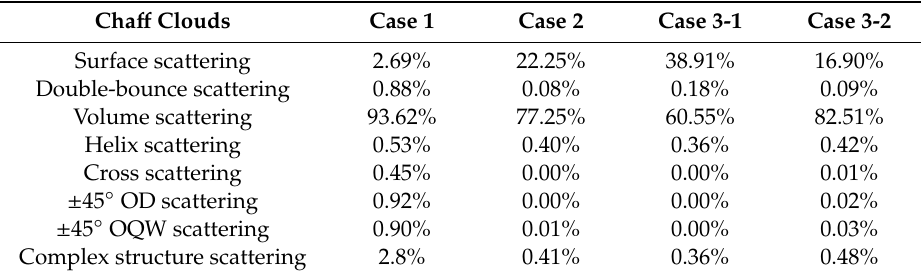
Figure 5. Decomposition results for chaff clouds in different cases. ( a ) Case 1. ( b ) Case 2. ( c ) Case 3-1. ( d ) Case 3-2. (red: double-bounce scattering, green: volume scattering, blue: surface scattering). Table 1. Scattering contribution statistics for chaff clouds.